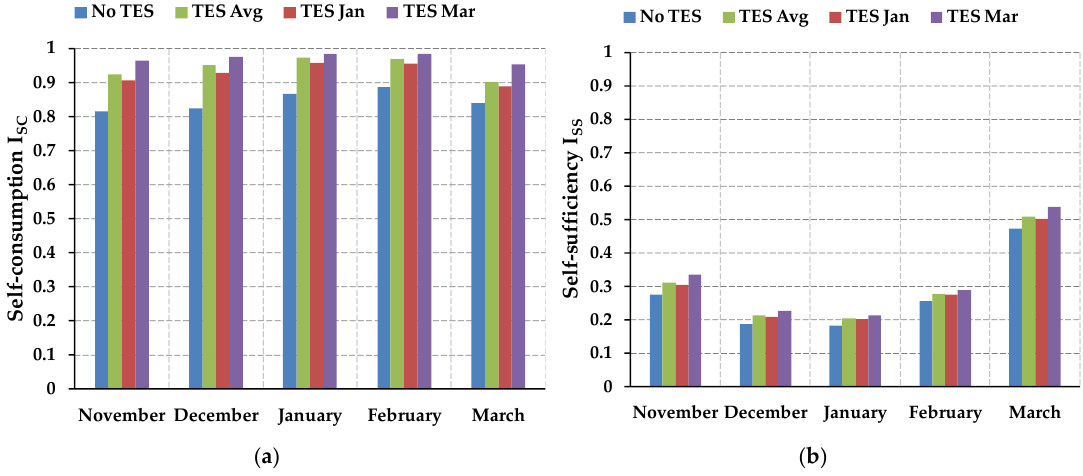
Figure 8. ( a ) Self-consumption index 𝐼 𝑆𝐶 and ( b ) self-sufficiency index 𝐼 𝑆𝑆 for all the winter months.